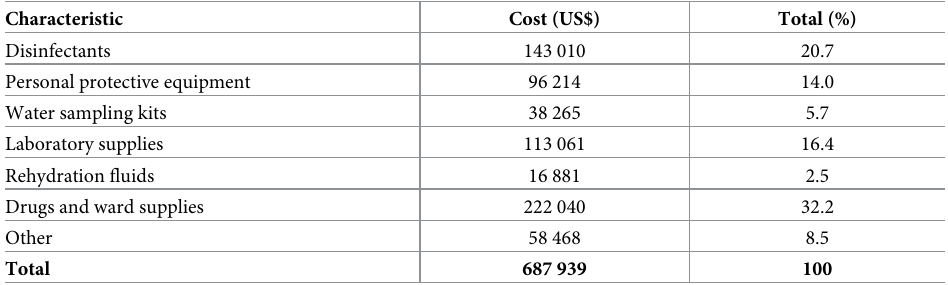
Table 6. Total direct costs incurred by the Ministry of Health and health facilities during cholera